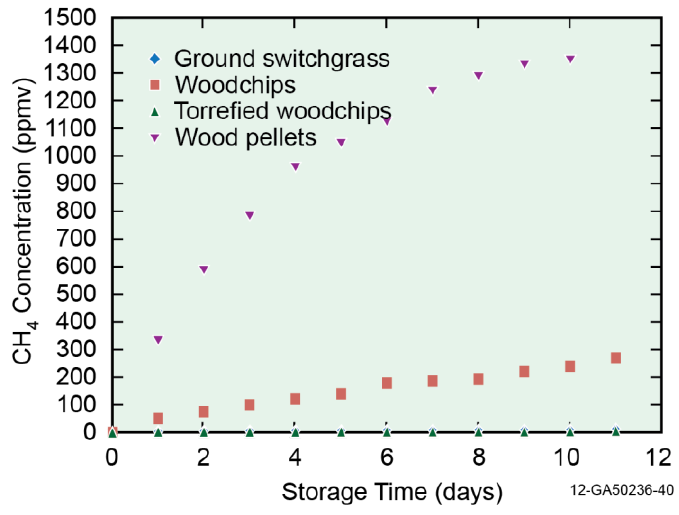
Figure 7. CH 4 concentration at 40 °C storage